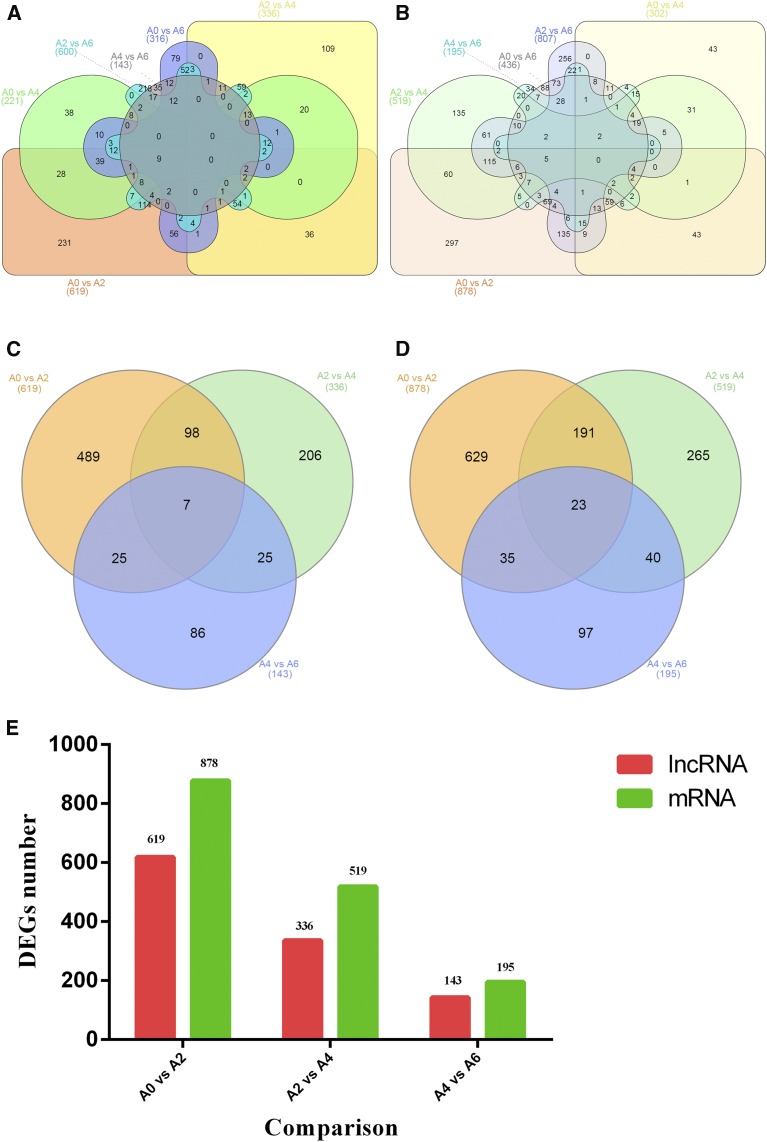
Venn diagram of differentially expressed genes (DEGs) at different stages. (A) Venn diagram of six comparisons of common lncRNAs (A0 vs. A2; A0 vs. A4; A0 vs. A6; A2 vs. A4; A2 vs. A6; and A4 vs. A6). (B) Venn diagram of six comparisons of common mRNAs (A0 vs. A2; A0 vs. A4; A0 vs. A6; A2 vs. A4; A2 vs. A6; and A4 vs. A6). (C) Venn diagram of three comparisons of common lncRNAs (A0 vs. A2; A2 vs. A4; and A4 vs. A6). (D) Venn diagram of three comparisons of common mRNAs (A0 vs. A2; A2 vs. A4; and A4 vs. A6). (E) Histogram of three comparisons of the number of DEGs.